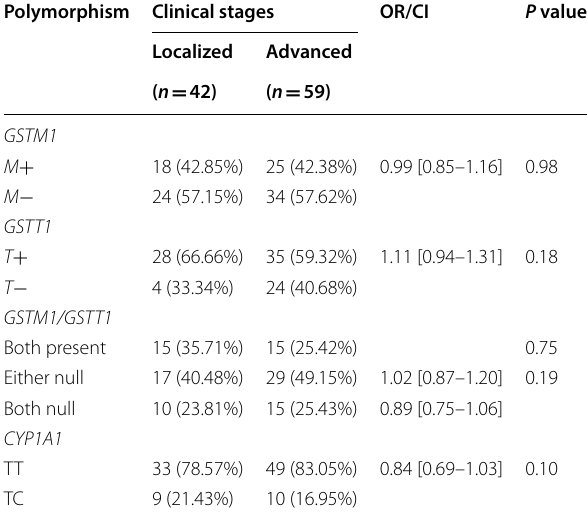
Table 3 GSTM1, GSTT1 genotypes distribution among tested patients and healthy controls and susceptibility of PCa